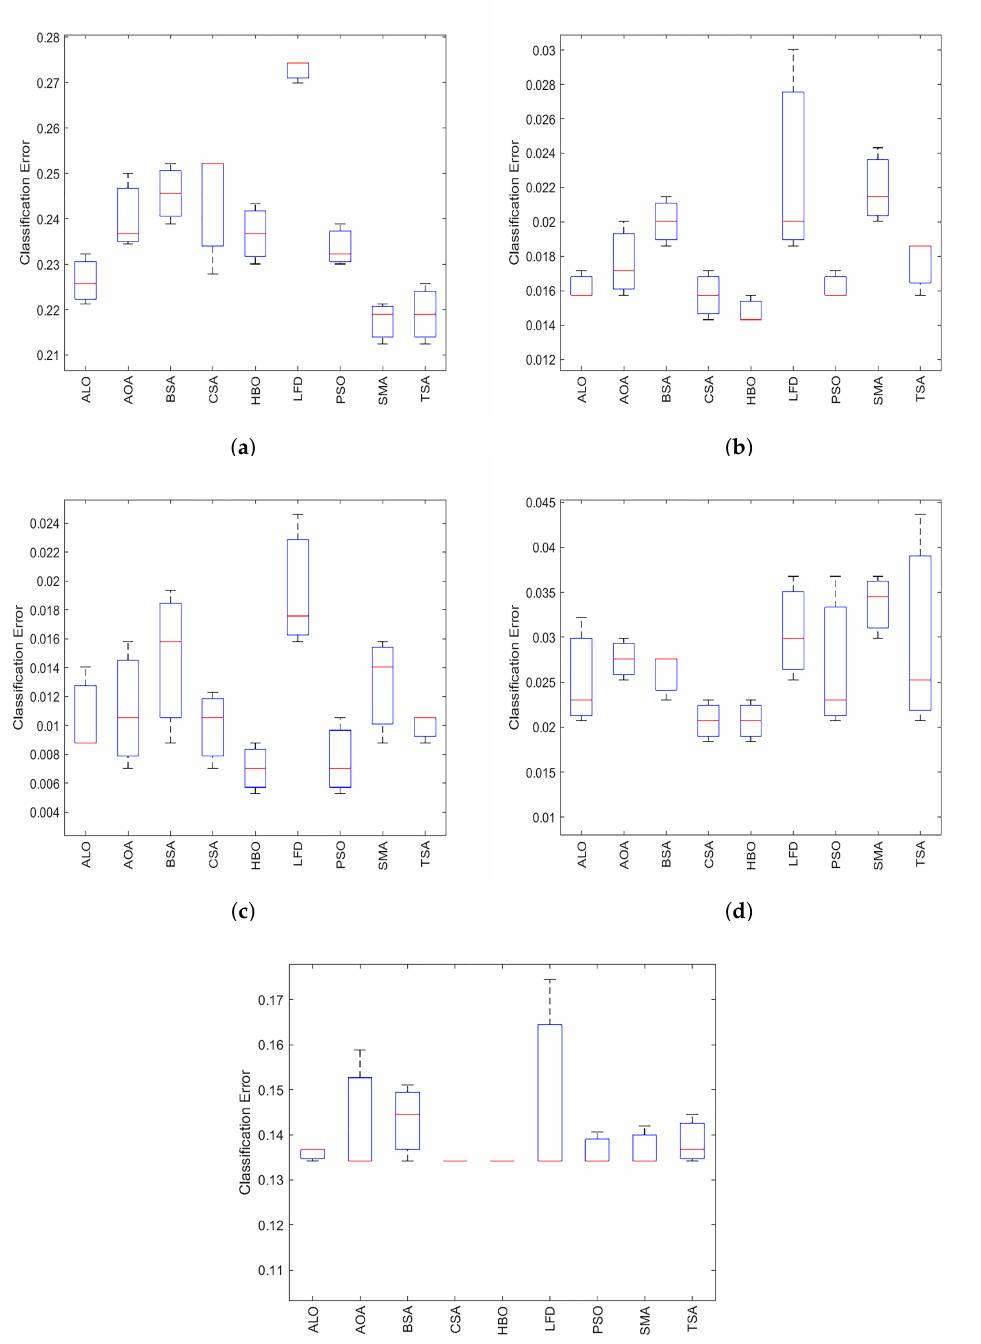
Figure 6. ( a ) Classification error of the proposed approach for Arrhythmia dataset; ( b ) Classification error of the proposed approach for Breastcancer dataset; ( c ) Classification error of the proposed approach for BreastEW dataset; ( d ) Classification error of the proposed approach for Congress dataset; ( e ) Classification error of the proposed approach for Diabets